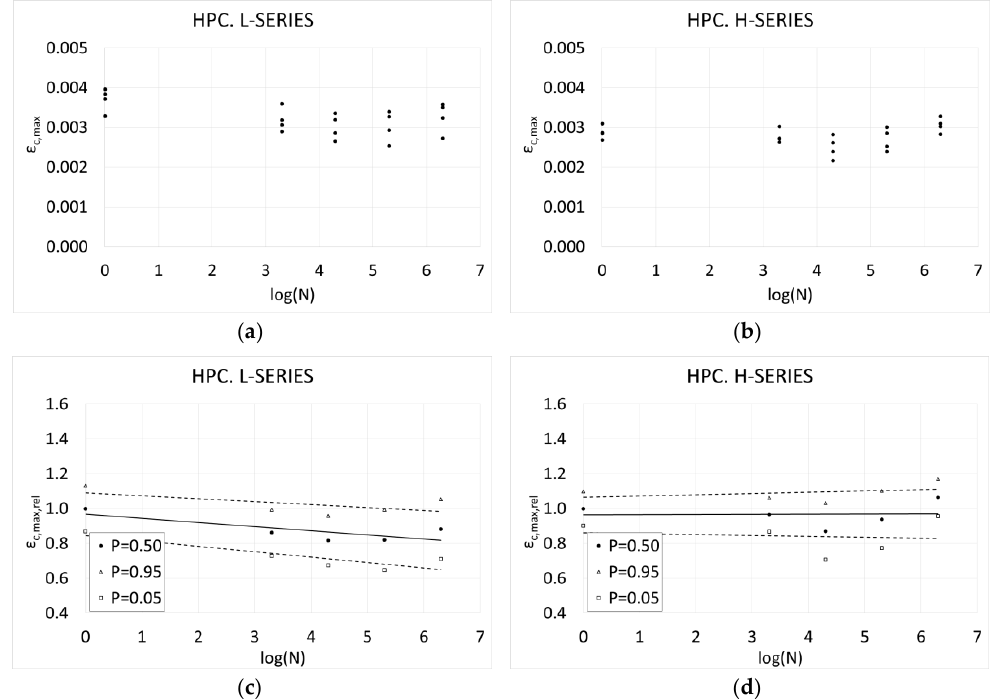
Figure 10. Range of maximum compressive strain by number of cycles. HPC ( a ) L-Series. Raw values. ( b ) H-Series. Raw values. ( c ) L-Series. Maximum, minimum, and average relative values, and tendency lines. ( d ) H-Series. Maximum, minimum, and average relative values, and tendency lines.